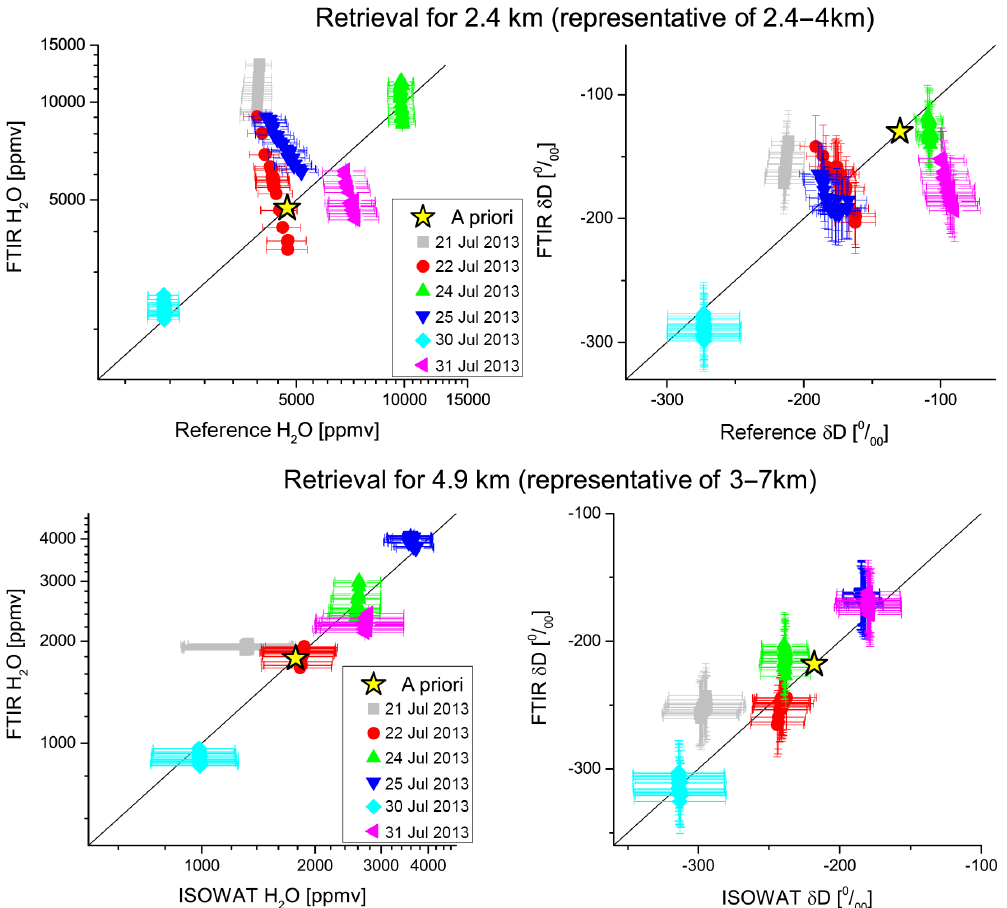
Figure C2. Same as Fig. 3, but for FTIR measurements corresponding to best temporal coincidences (FTIR observations made during the 3h of the aircraft flights, typically 10:30–13:30